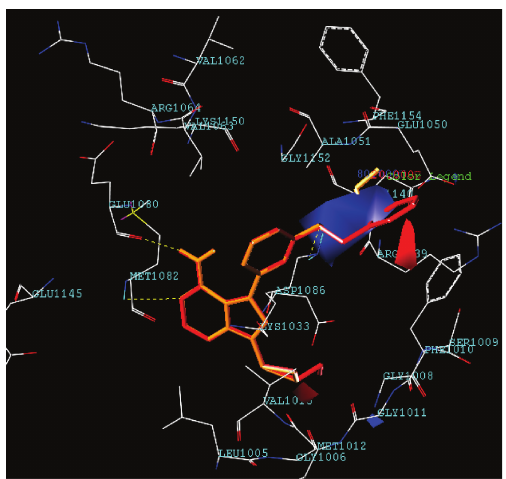
Figure 4: CoMSIA electrostatic maps with the most (red) and least (orange) active compound within the active site.